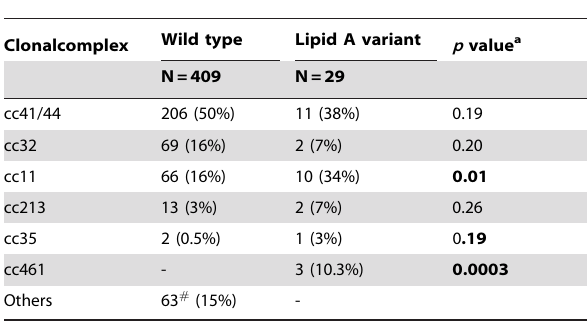
Table 2. Clonal complex distribution of lipid A variants among isolates from patients with invasive meningococcal